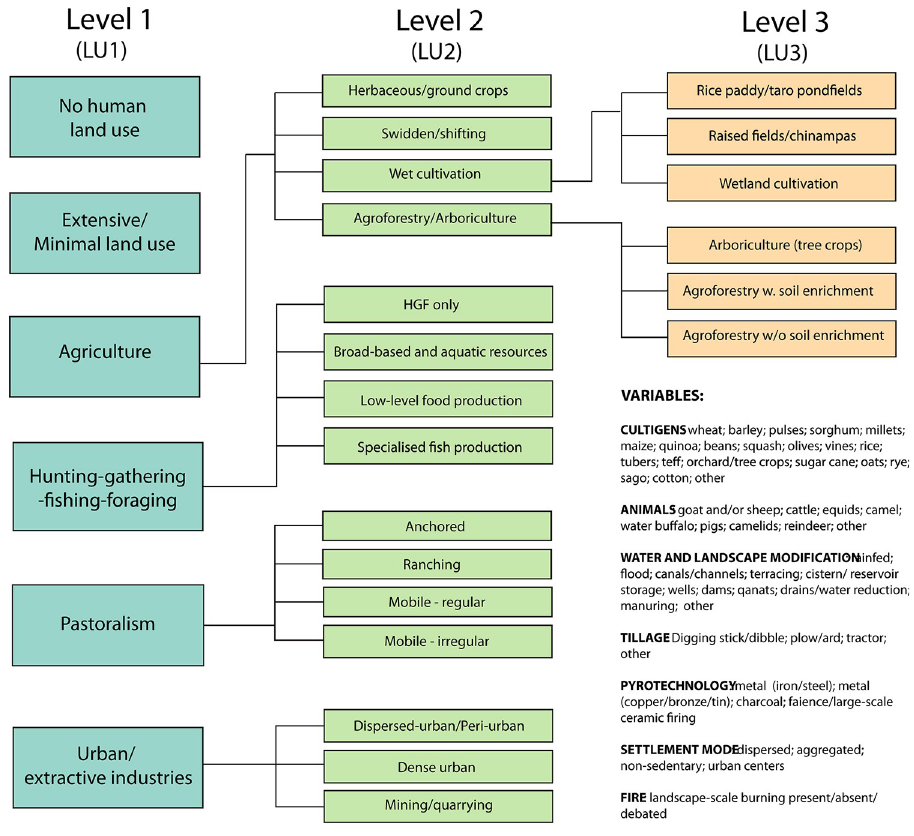
Fig 1. The PAGES LandCover6k land use classification